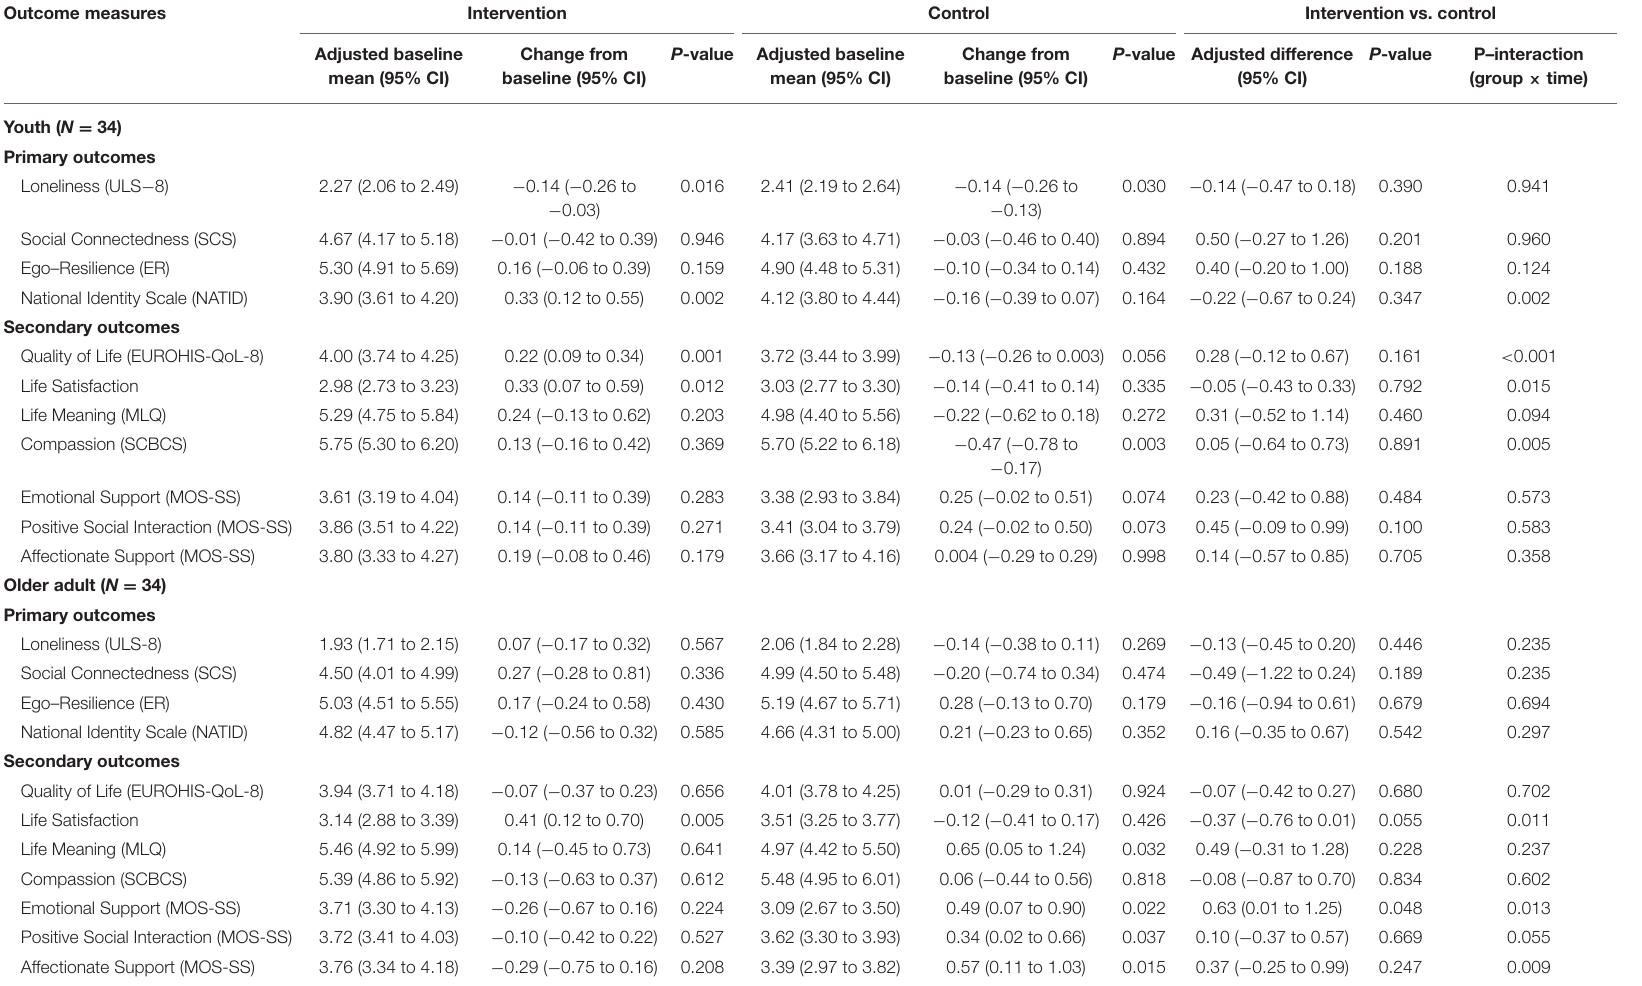
CI, confidence interval; models adjusted for age, gender, ethnicity, education, marital status, employment, income, type of residence, and self–reported chronic